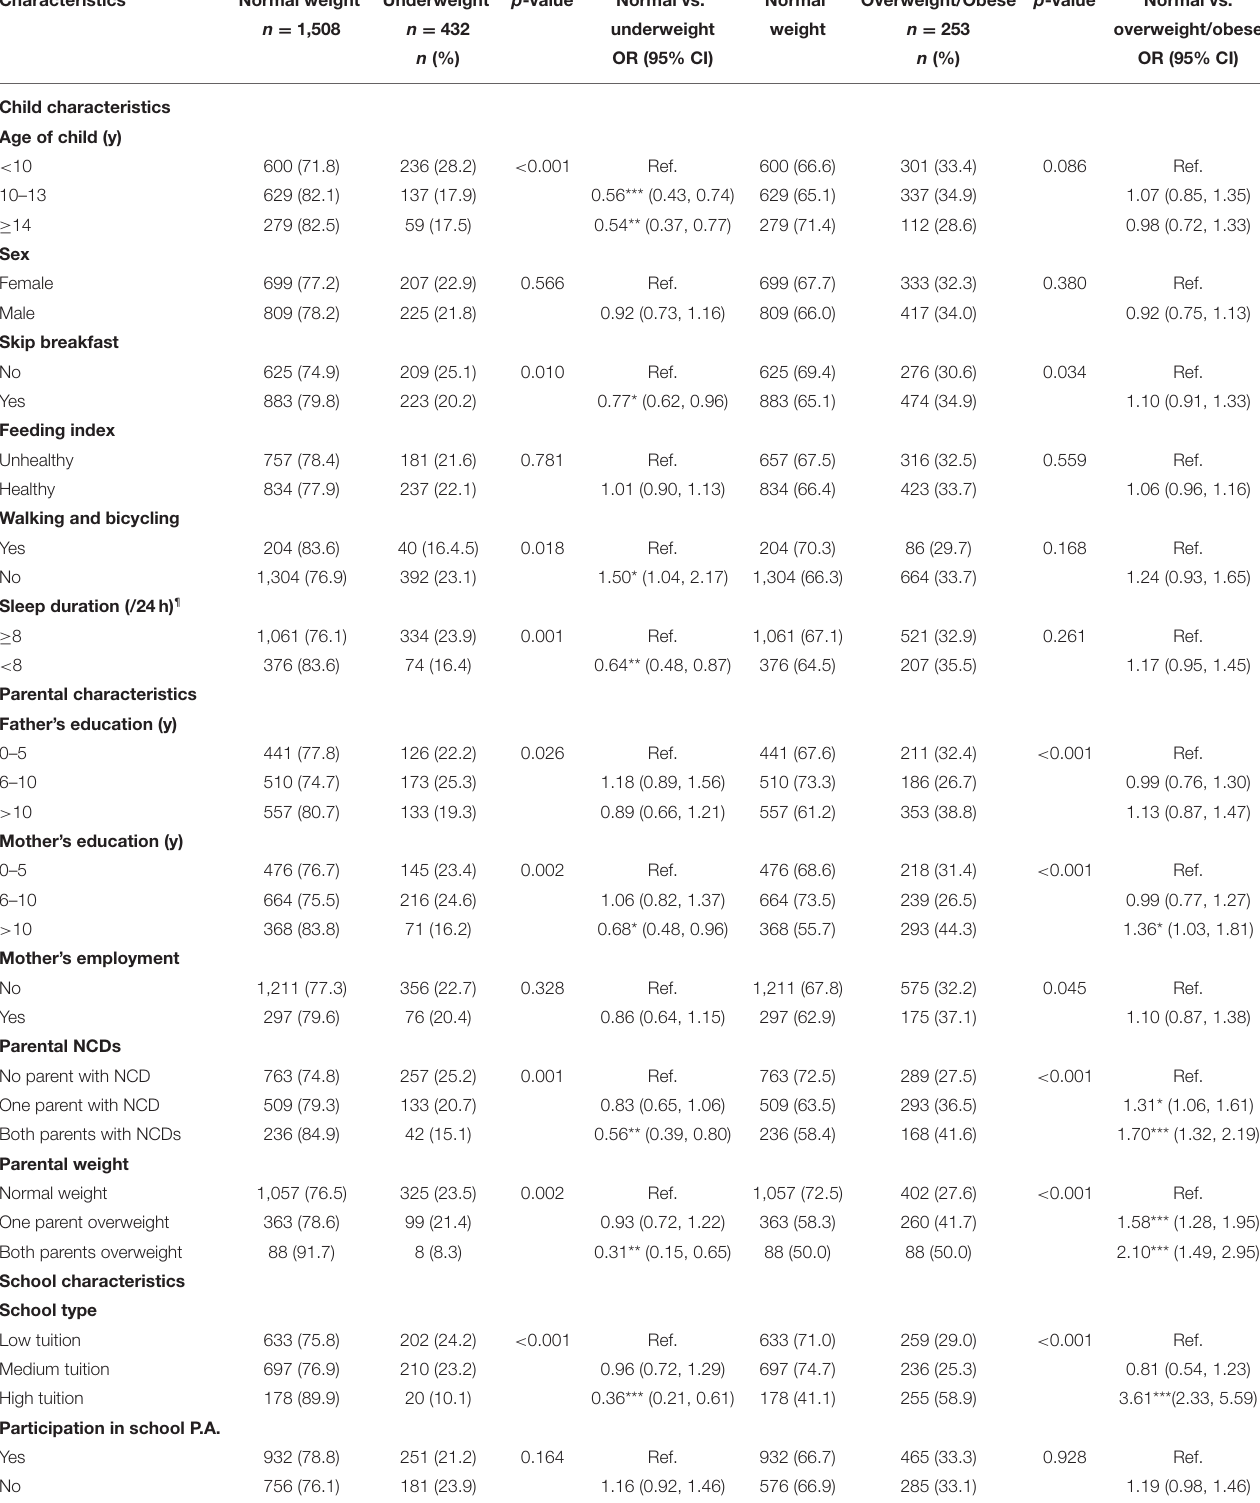
TABLE 3 | Association between underweight and overweight/obesity with background characteristics. Characteristics Normal weight Underweight p -value Normal vs. Normal Overweight/Obese p -value Normal vs. n = 1,508 n = 432 underweight weight n = 253 overweight/obese n (%) OR (95% CI) n (%) OR (95%